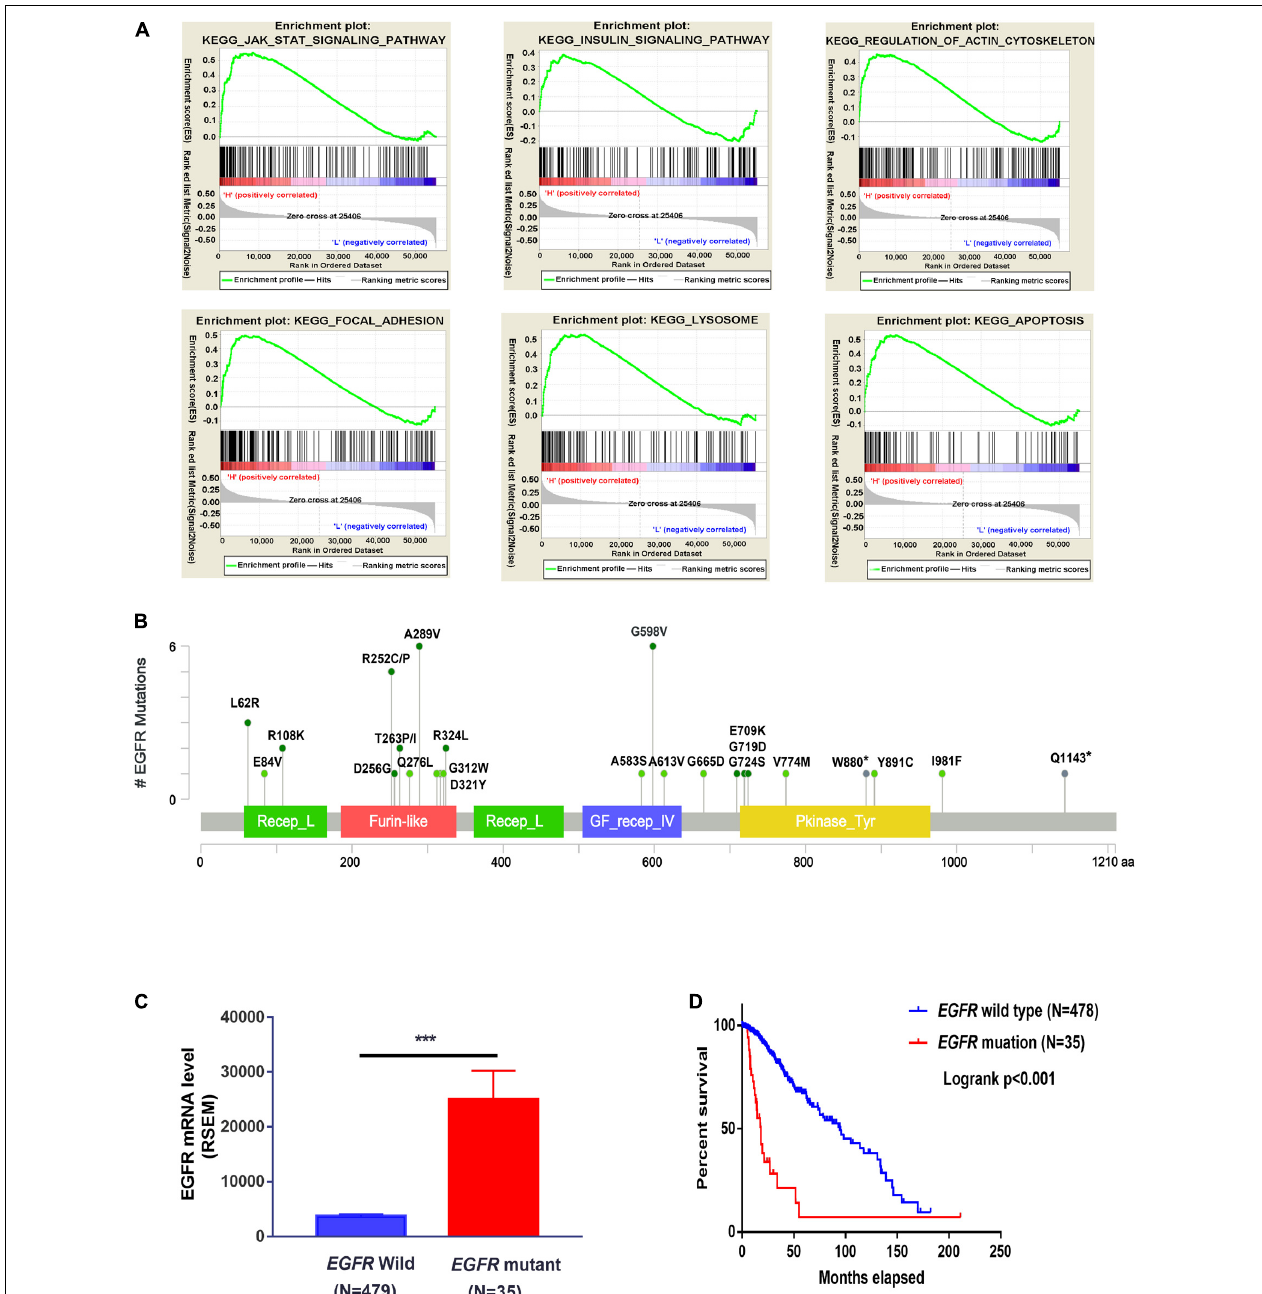
FIGURE 3 | Functional analysis of EGFR in LGG cohorts. (A) GSEA analysis of EGFR in the TCGA-LGG cohort. (B) EGFR mutation sites were analyzed three LGG cohorts from cBioportal. (C) The expression difference of wild-type EGFR and mutated EGFR in TCGA-LGG patients (TCGA, PanCancer Atlas). (D) The survival probability of LGG patients with or without EGFR mutation (TCGA, PanCancer Atlas). *** P < 0.001.